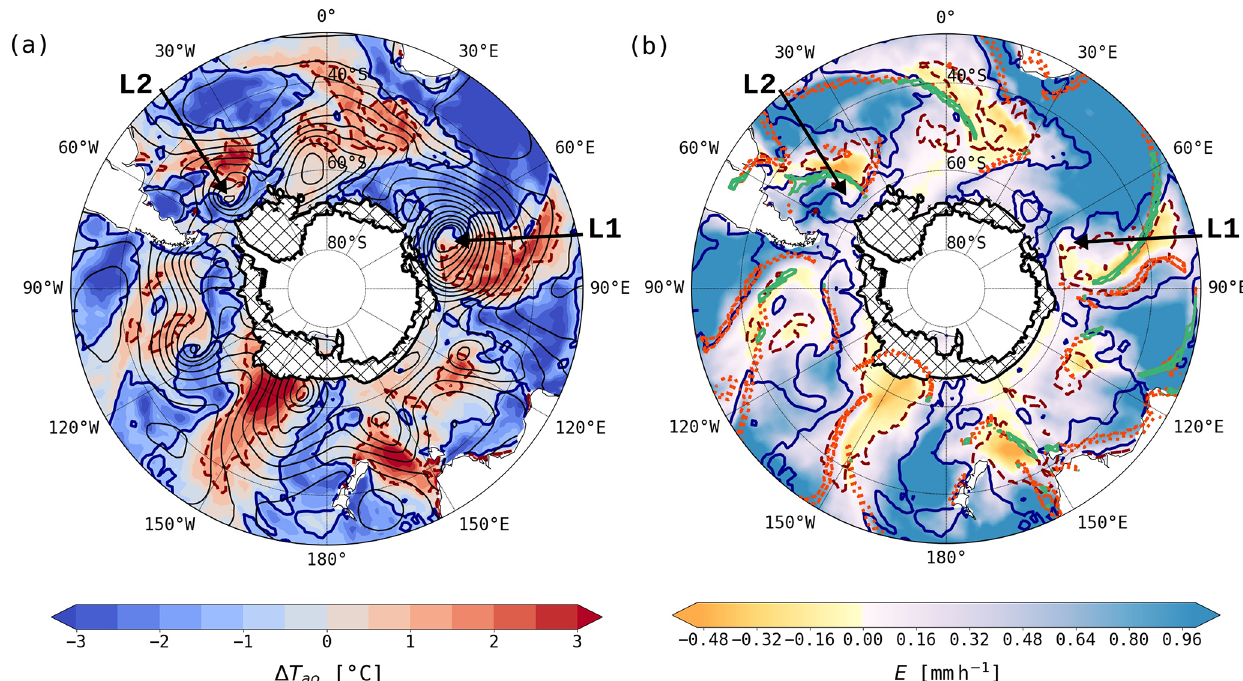
Figure 3. An example of cold and warm temperature advection events in the Southern Ocean at 12:00UTC on 26 December 2016 from ERA- Interim. (a) Air–sea temperature difference (cid:49)T ao using T at 10ma.s.l. (colours). Grey contours show sea level pressure in 5hPa intervals. (b) Ocean evaporation E (colours) and surface cold (green contours) and warm (orange contours) fronts. Contours of (cid:49)T ao = − 1 . 0 ◦ C (blue, solid) indicate cold temperature advection events and of (cid:49)T ao = 1 . 0 ◦ C (red, dashed) warm temperature advection events, respectively. Land areas and areas covered by at least 1% sea ice are blanked. Additionally, the blanked sea ice areas are hatched. L1 and L2 mark cyclones discussed in the